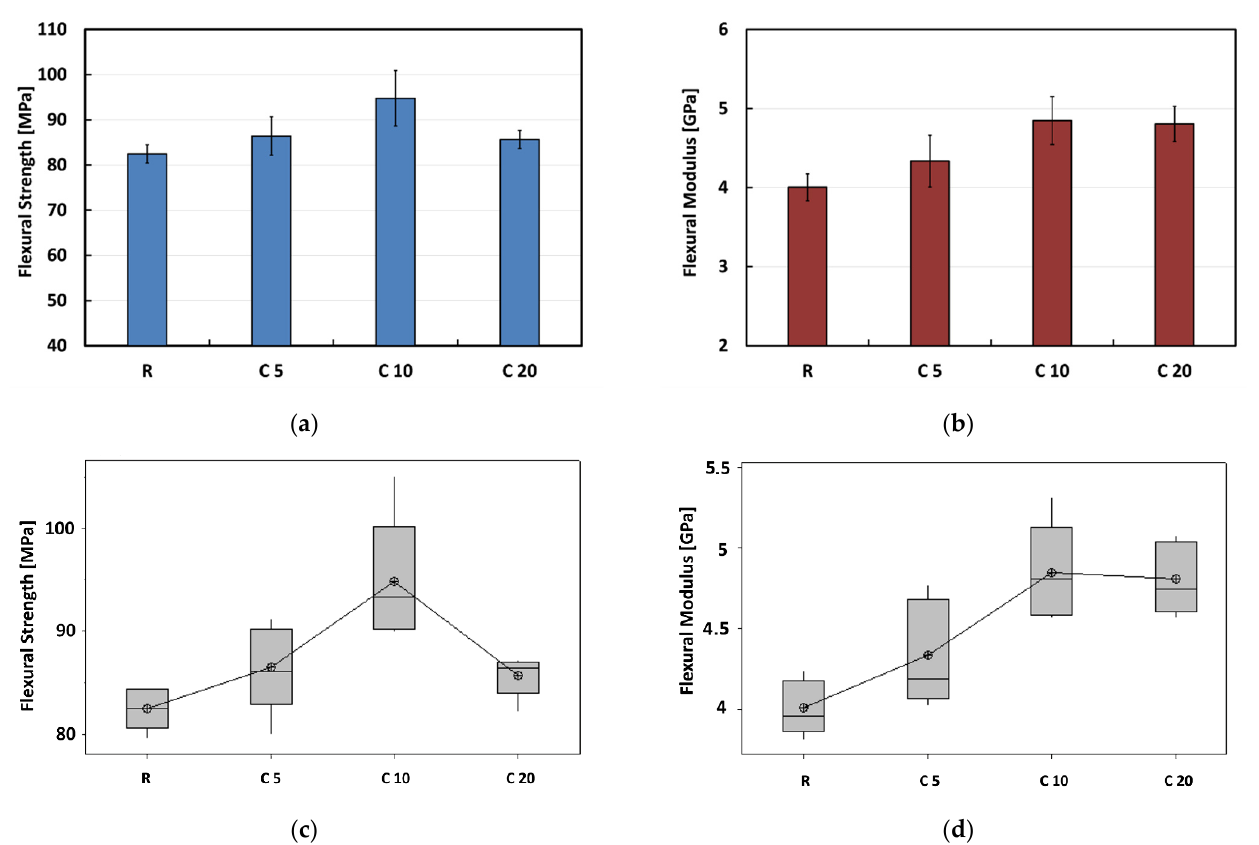
Figure 3. Flexural properties ( a , b ) bar chart and ( c , d ) box plot for each treatment condition.